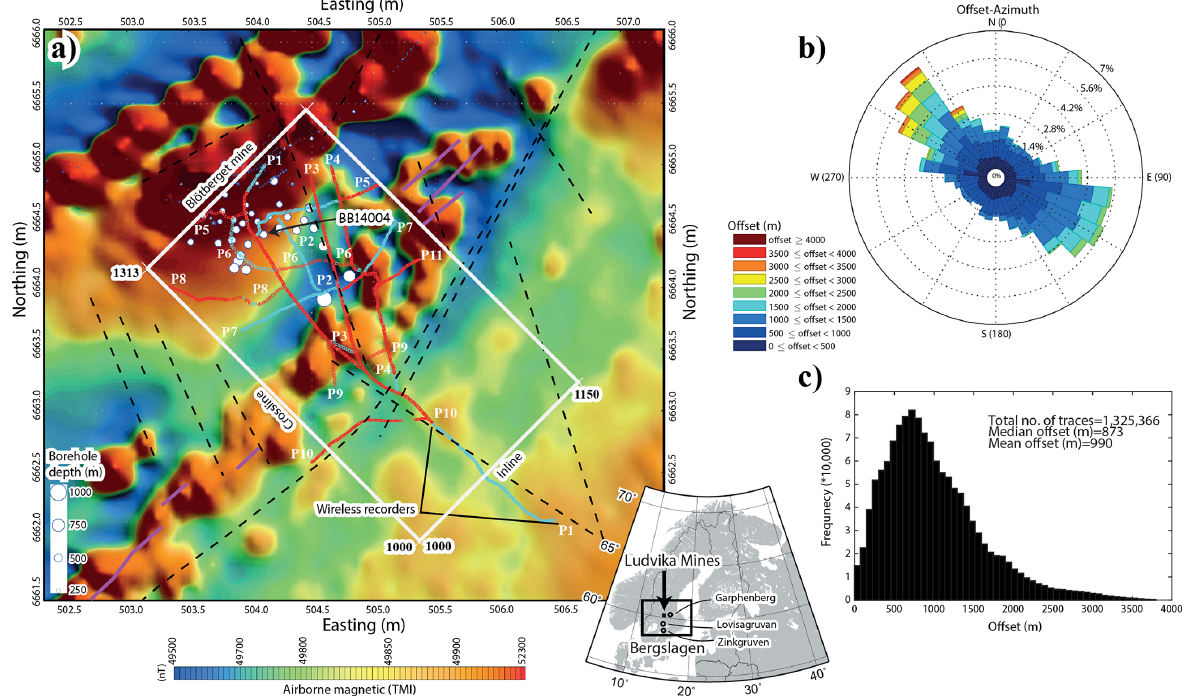
Figure 1. (a) Total-field aeromagnetic map of the Blötberget mine in central Sweden and the sparse 3D seismic survey area. P1–P11 were set up as part of the survey (fixed geometry). The red dots show the shot locations (1056 points), and the blue dots are the receiver locations (1266 points). P10 and P11 were added later to improve fold and azimuth coverage and comprise only shots. Along P1, several co-located 2D profiles have since 2015 been acquired (land streamer survey in 2015 and conventional plant-type geophones in 2016). Downhole logging data from BB14004 are presented in this study. (b) Offset-azimuth coverage showing a narrow azimuth survey setup primarily for targeting the known southeast dipping of the iron oxide deposits and (c) an offset distribution showing a median offset of approximately 900m for the whole dataset. Magnetic data were provided by the Geological Survey of Sweden. Dashed lines in (a) are topographic and structural lineaments extracted from the geological map of the study area. Solid purple lines are interpreted as